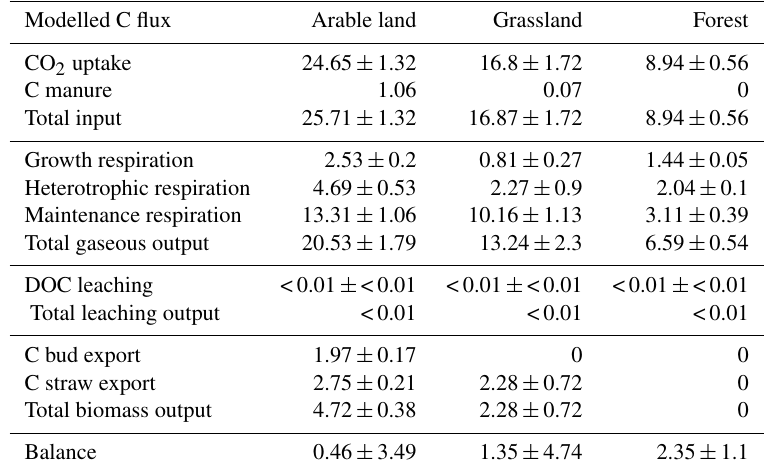
Table 5. Simulated carbon fluxes given by posterior model runs and their uncertainty on different land use in t Cha − 1 a − 1 . C manure on grassland includes input by sheep’s dung. Arable land model assumes 20% return of stubble to field.